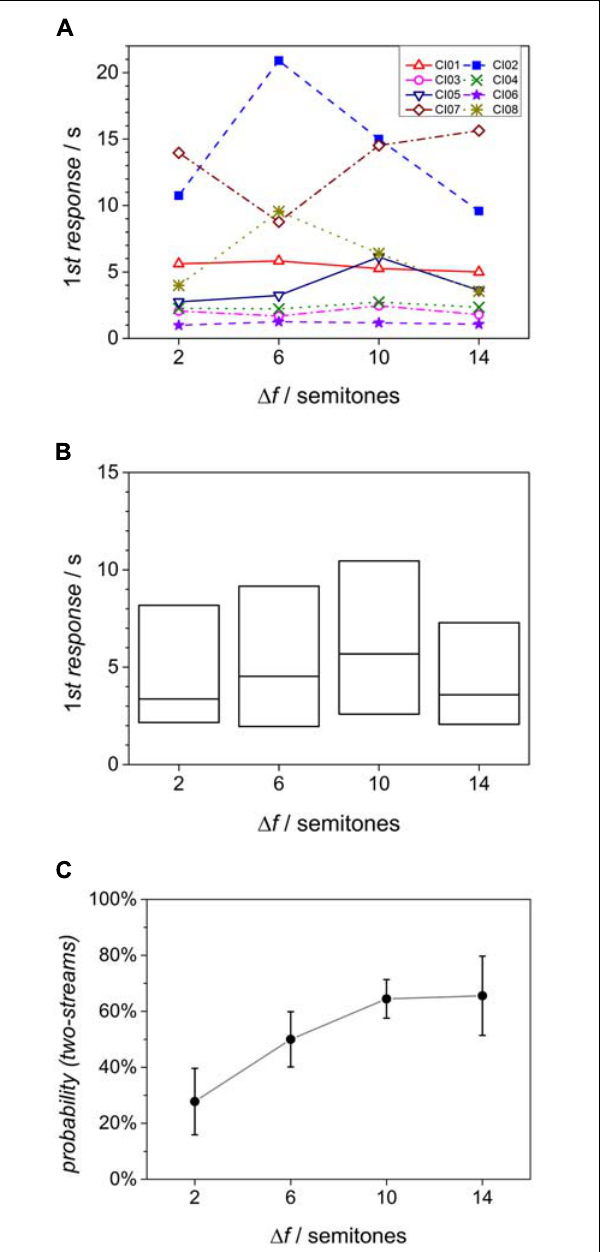
FIGURE 3 | (A) Time of the first response; individual values from eight listeners. (B) Box plot of the time of first response. Box boundaries mark the lowest and highest quartiles, center lines the median. (C) Type of first decision for different (cid:2) f conditions.